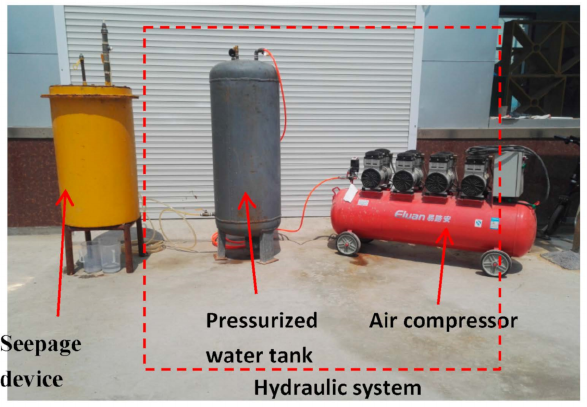
Figure 4. The seepage erosion test